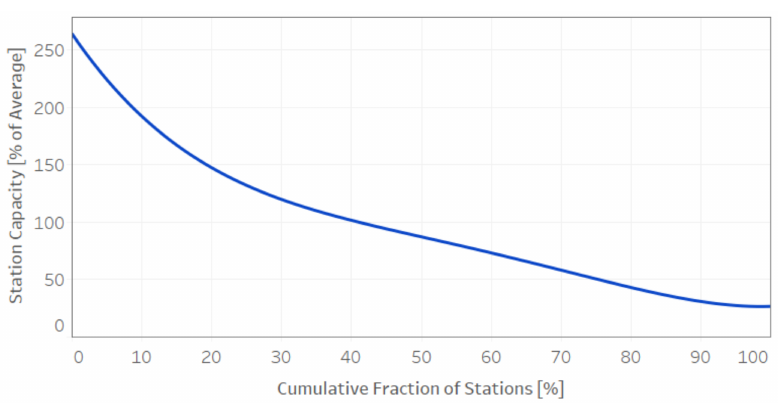
Figure 4. Generic station capacity distribution [42]. Algorithm 3. Station Fine-Grid Placement